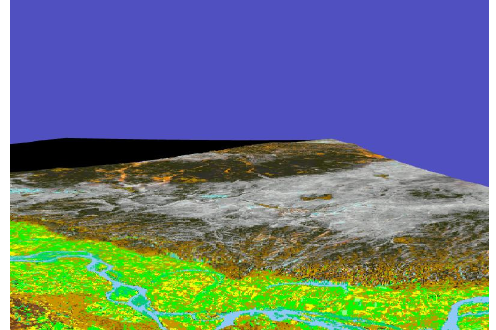
Figure 3. A3D landscape reconstruction of Jebel Bishri and the Euphrates valley seen from N. The image is displaying the geomorphology, such as caused by the run-off mechanism leading waters coming from the mountain into the